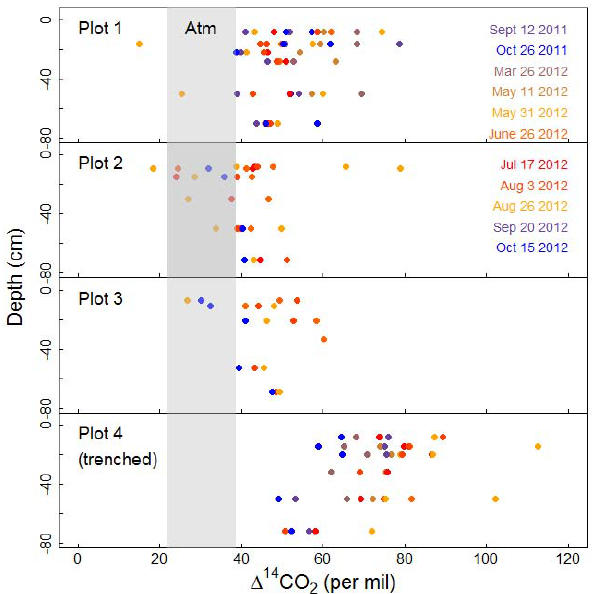
Fig. 2. Soil air 14 CO 2 for intact and trenched plots. Grey bar shows range of atmospheric 14 CO 2 . Error bars not shown for clarity, un- certainty for 1 14 CO 2 measurements ranged approximately 2–9‰ (see methods).